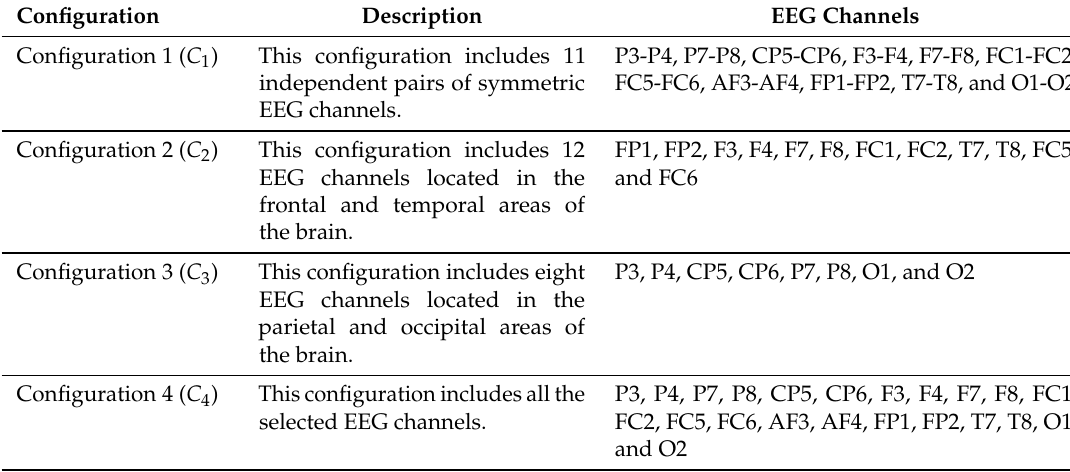
Table 5. The four configurations of EEG channels considered in this